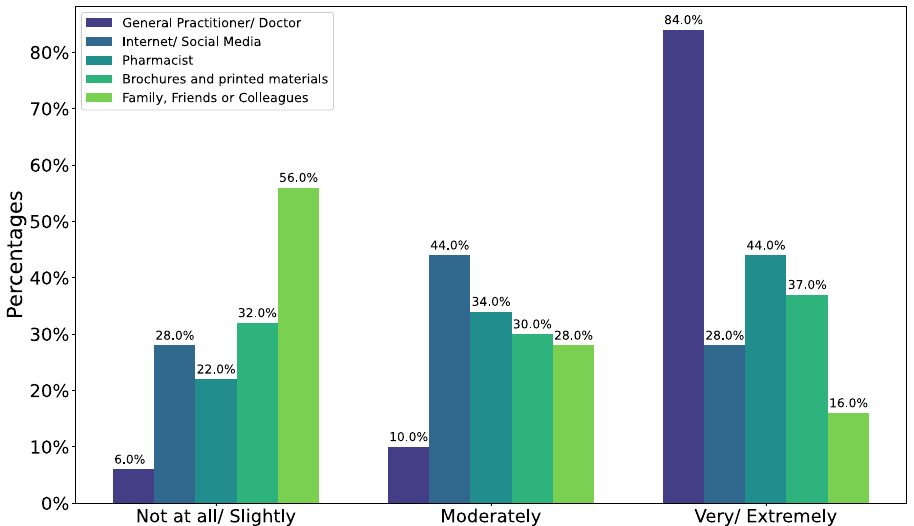
Figure 2. The figure shows how trustworthy different sources of knowledge were ranked by participants using 5-item Likert scales. During analysis, the responses were collapsed into 3-item